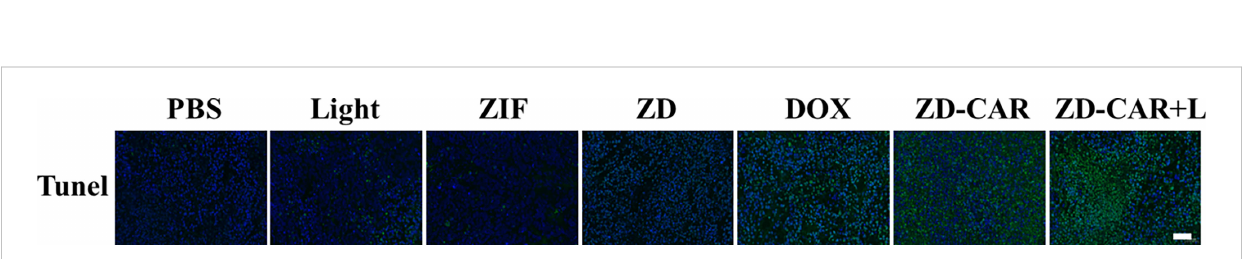
FIGURE 14 Fluorescence microscopy images of H&E tumor tissues after various treatments. (Scale bar is 100 m